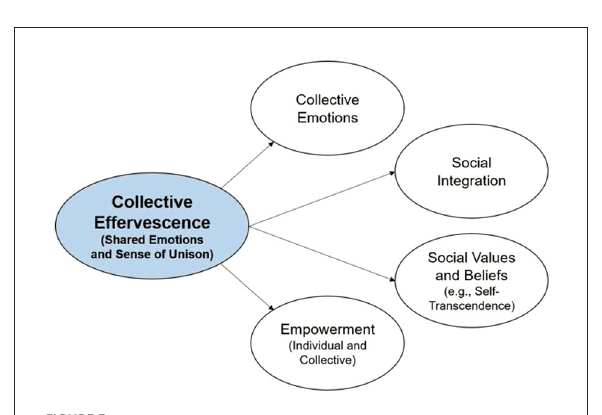
FIGURE3 Distal outcomes of collective